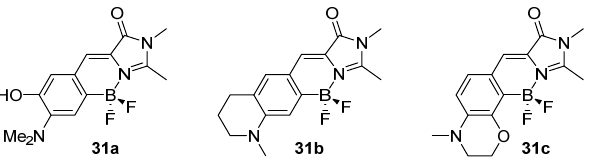
Figure 29. GFPc analogues with solvent-dependent quantum yield ( 31a ) or not ( 31b,c ) [47].